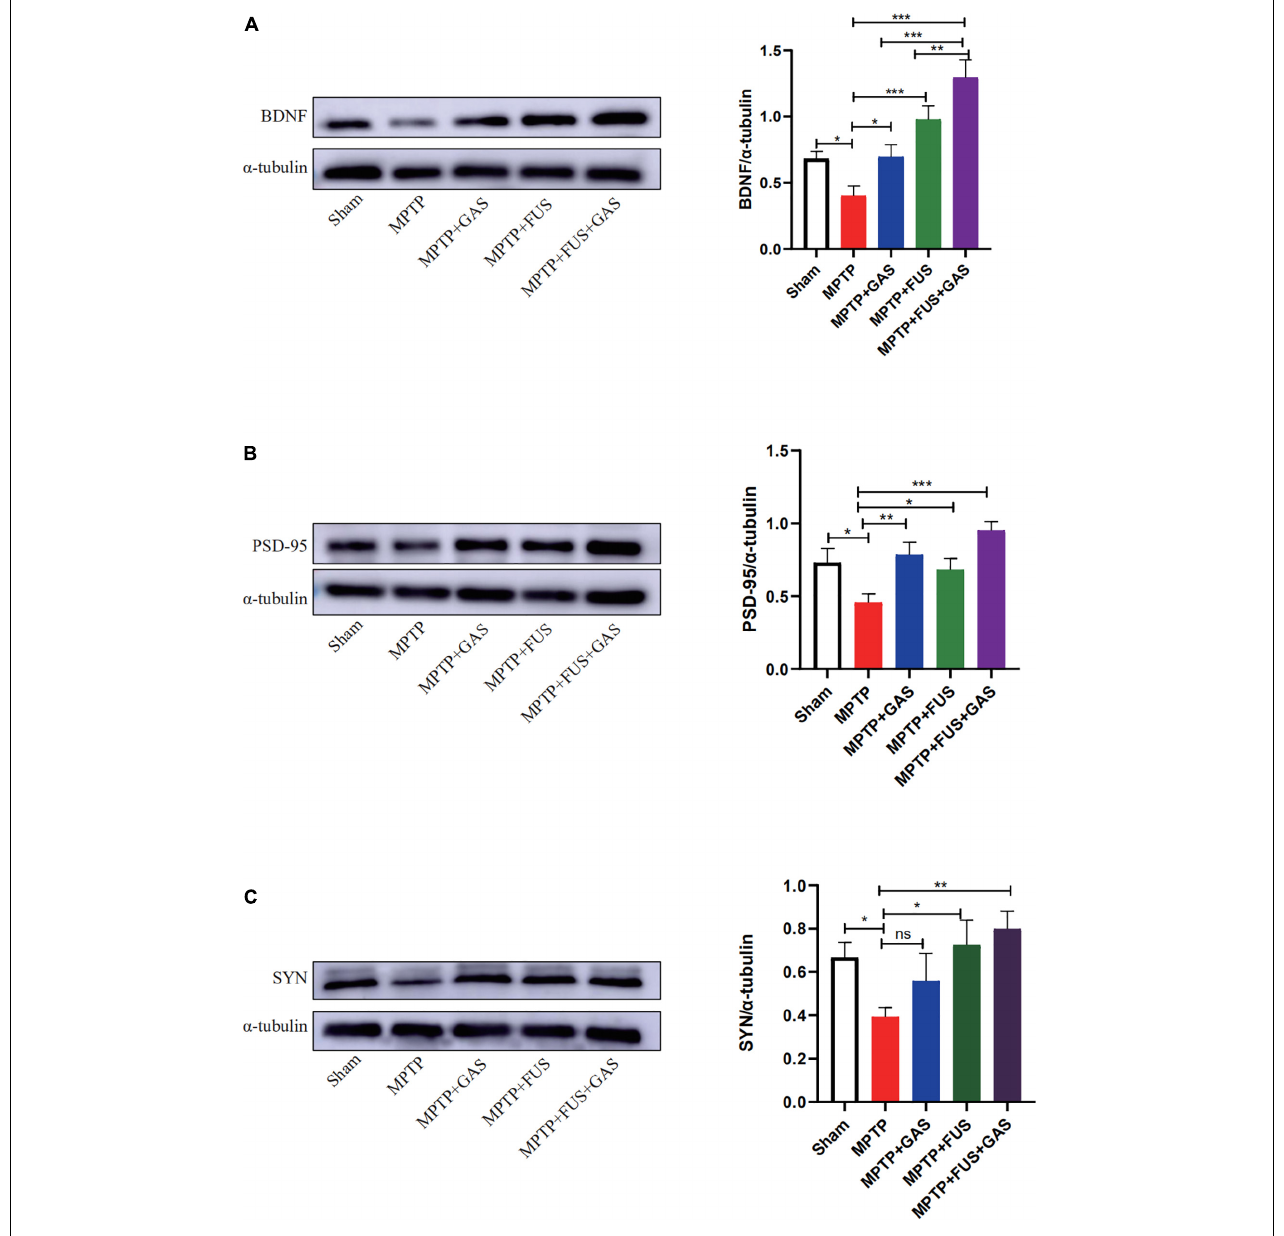
FIGURE 6 | (A–C) Changes in the protein expression of brain-derived neurotrophic factor (BDNF), postsynaptic density protein 95 (PSD-95), and synaptophysin (SYN) in the left striatum of mice in each group. Compared to MPTP group, * P < 0.05 compared to MPTP group; ** P < 0.01; *** P < 0.001, no significance (ns), P > 0.05. One-way ANOVA with LSD test; n = 5, mean ±